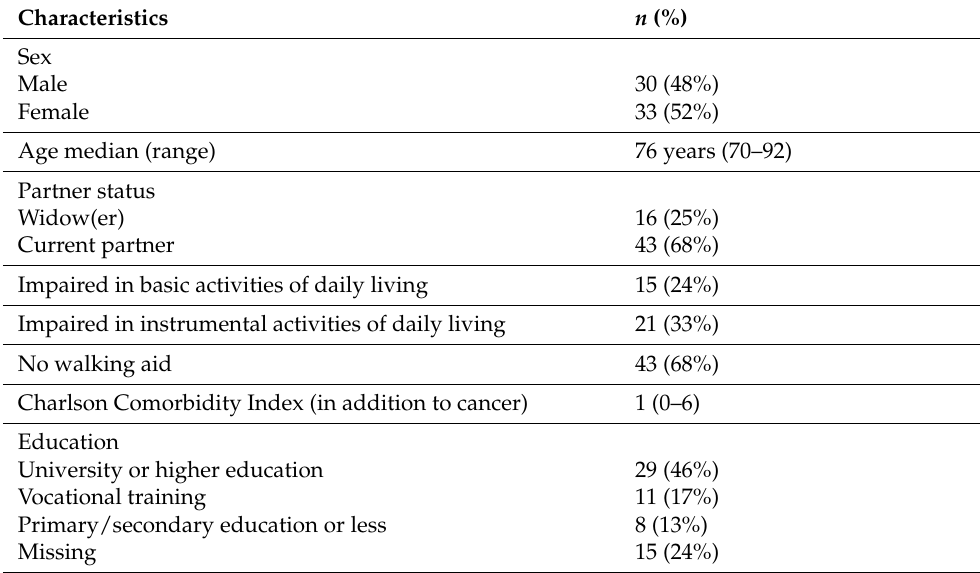
Table 2. Demographics of the